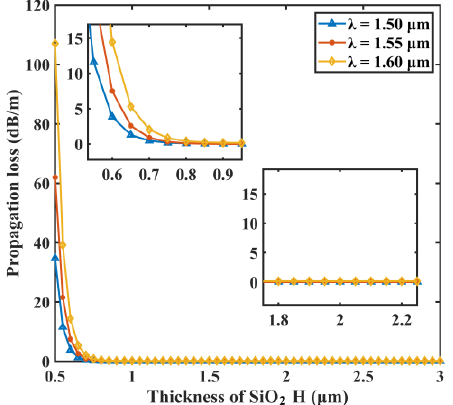
Figure 8. The variation curves of propagation loss with the thickness of SiO 2 H at different wavelengths in the BIC straight waveguide is simulated when the waveguide width is 1.336 μm.